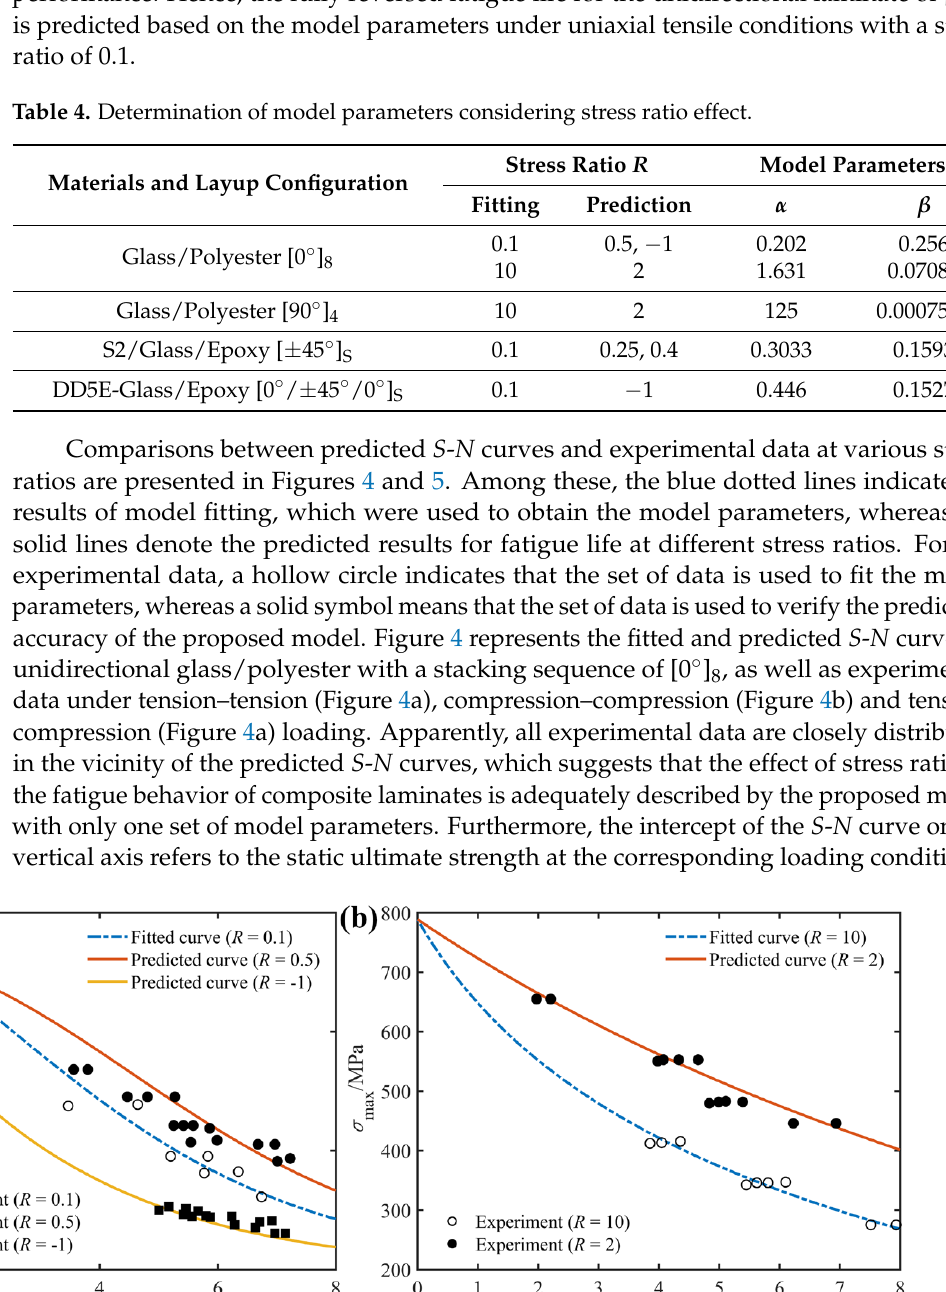
Table 4. Determination of model parameters considering stress ratio effect.